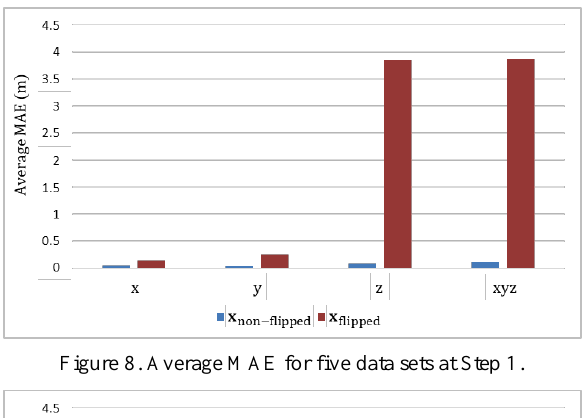
Figure 8. Average MAE for five data sets at Step 1.